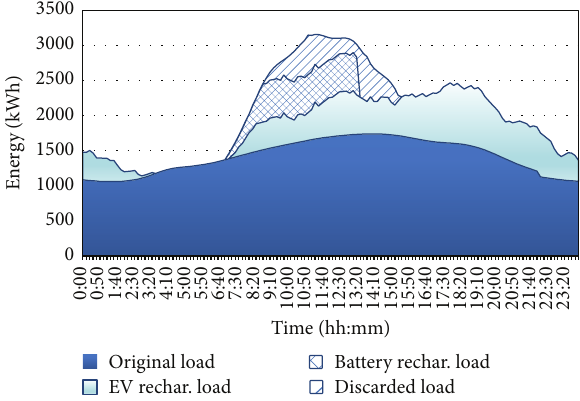
Figure 11: HRES energy consumption with 100% EVSE penetration.